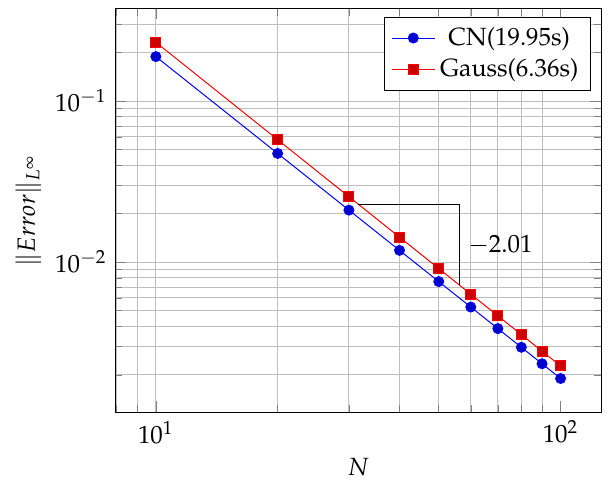
Figure 5. Convergence